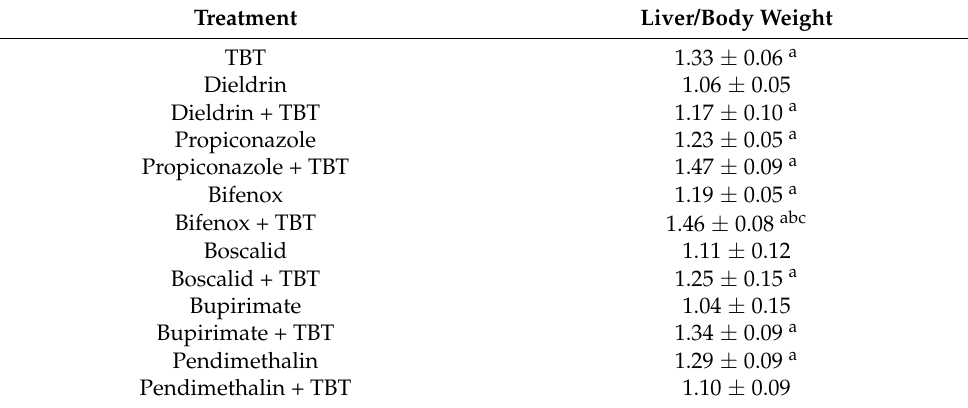
Table 2. Effect of pesticide treatment on liver/body weight. The liver-to-body weight ratios expressed in fold change of the DMSO group, (mean ± standard error). “a” indicates significant difference with DMSO, “b” with TBT, and “c” with pesticide treatment alone. p < 0.05 is considered significant according to one-way ANOVA test followed by Tukey’s multiple comparisons test. Treatment Liver/Body